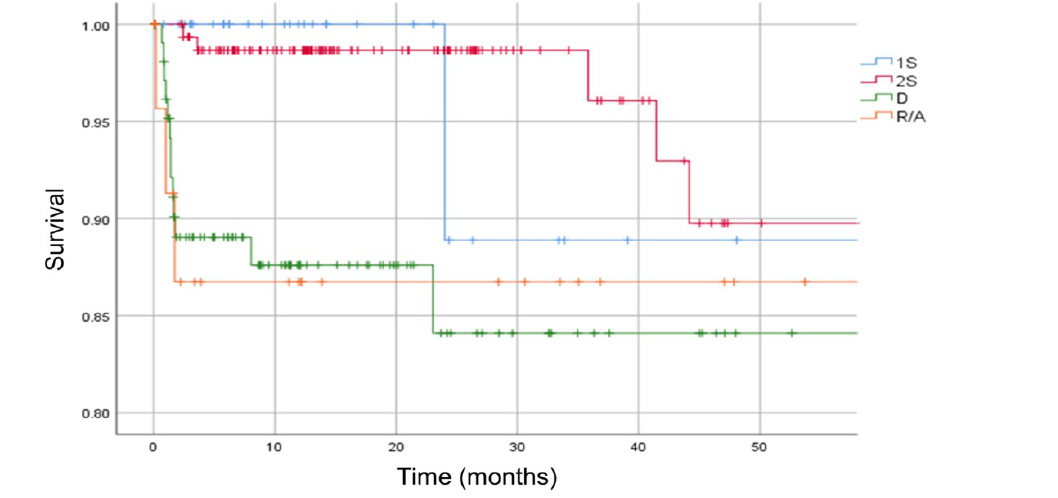
http://www.jbji.net